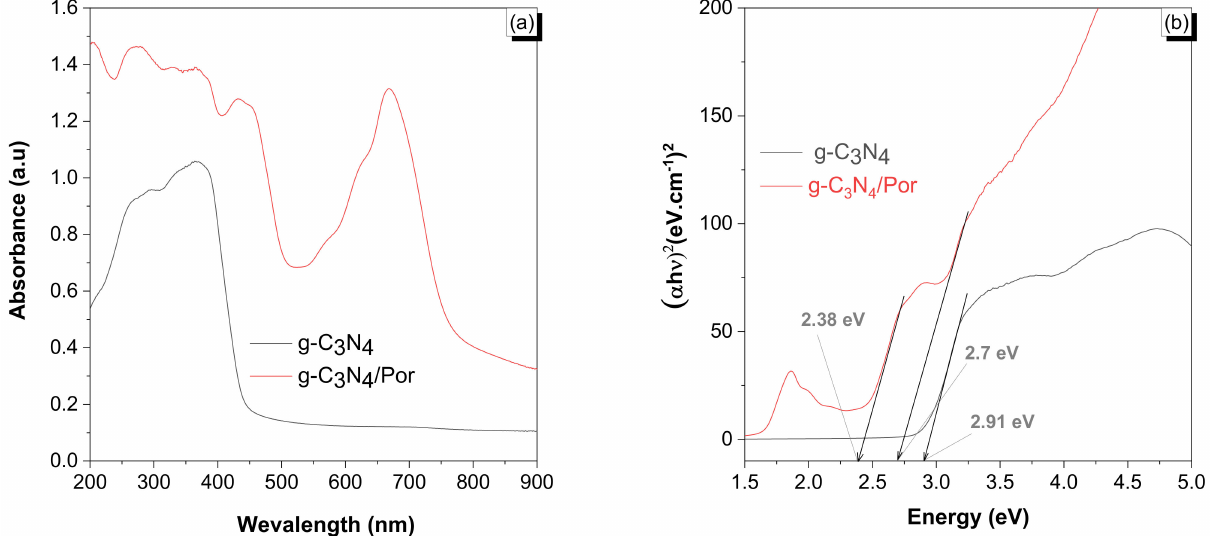
Figure 5. ( a ) The diffuse reflectance UV-Vis and ( b ) the Tauc plot of the free-standing g-C 3 N 4 and g-C 3 N 4 /porphyrin hybrid